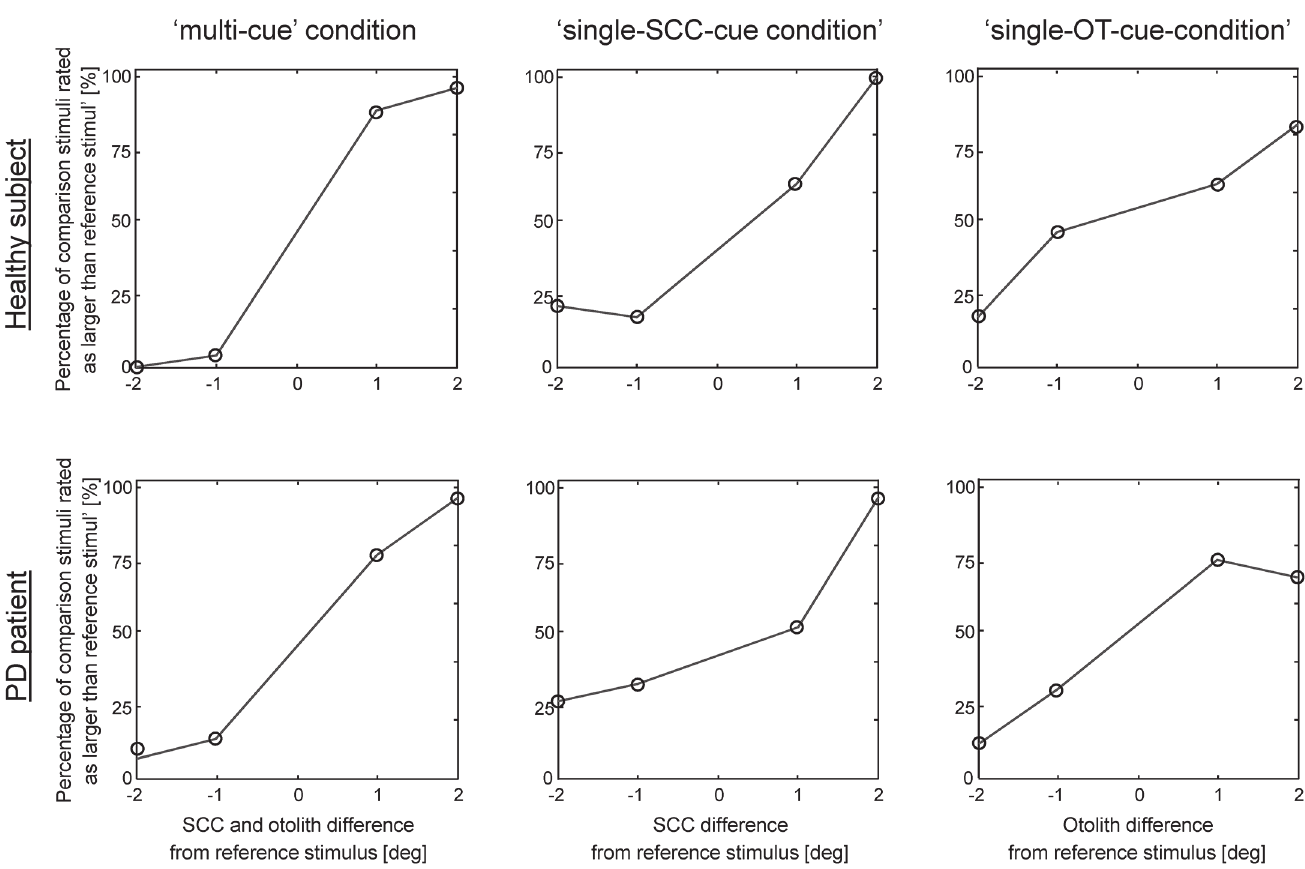
Fig 2. Discrete approximation of the psychometric curves (dots connected by gray lines) in one healthy subject (upper panel) and one PD patient (patient index ID5; lower panel) plotted for the three conditions in separate three separate graphs (from left to right: ‘ multi-cue ’ , ‘ single-SCC ’ and single-OT condition. Abscissa: difference of SCC and/or OT activation between the comparison and reference stimulus. Ordinate: percentage of times the comparison stimulus was rated as larger tilt movement than the reference stimulus. Each of the four data points in each graph correspond to percentage recorded in all the trials of one the four comparison stimuli tested in that